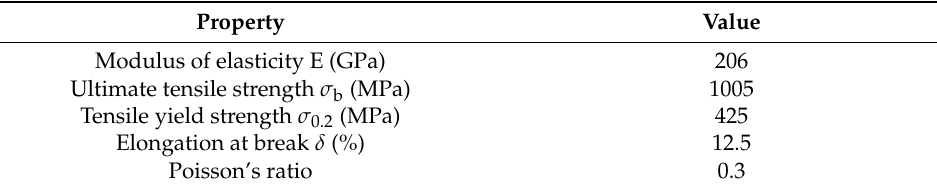
Table 2. Mechanical properties of 40CrMo